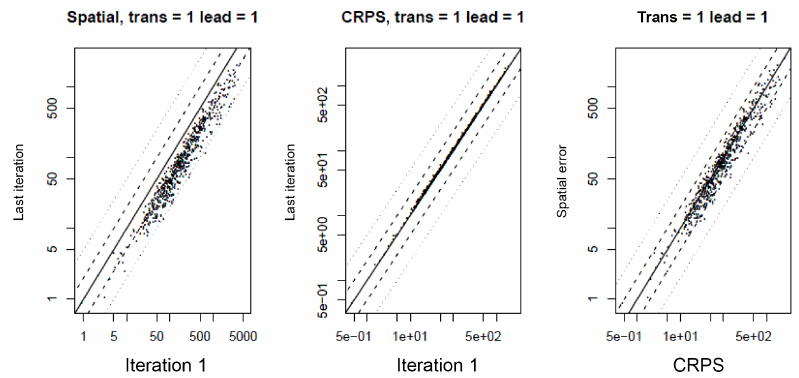
Figure 1. Left and central panel: Development of CRPS-errors and spatial errors from first to last iteration for lead time of one day. Right: Comparison of CRPS and spatial error after last iteration. Solid line represents 1 : 1, whereas dashed lines represent 2 : 1 and 1 : 2 and stapled lines 5 : 1 and 1 :